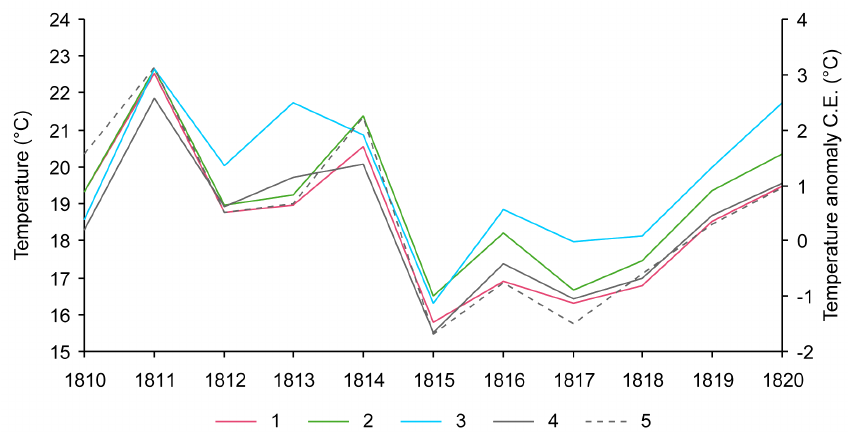
Figure 4. Differences between mean summer and winter temperatures in Prague-Klementinum (1), Žitenice (2), Brno (3), Czech Lands (4) and central Europe (5; C.E.) series, demonstrating reduction of seasonality after the Tambora eruption in 1815. Central European differences are calculated from temperature anomalies with respect to the 1961–1990 reference period (right